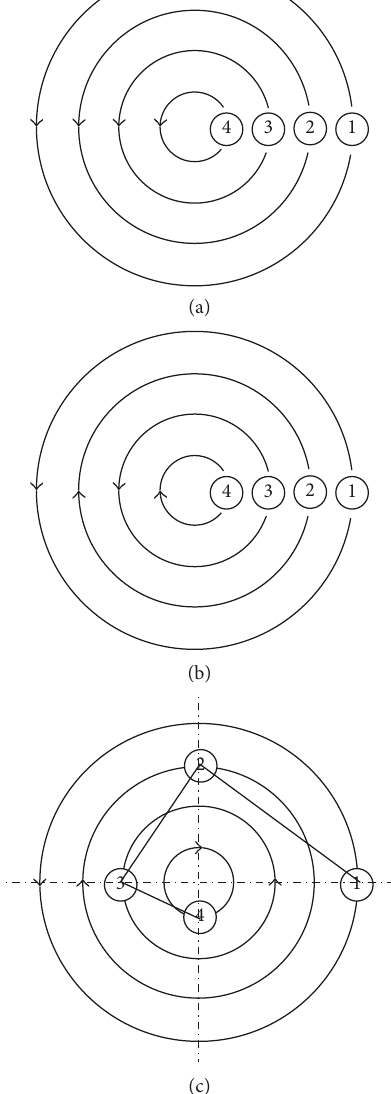
Figure 13: Three different forming trajectories: (a) the single forming trajectory, (b) the alternating inversion trajectory, and (c) the uniform press point